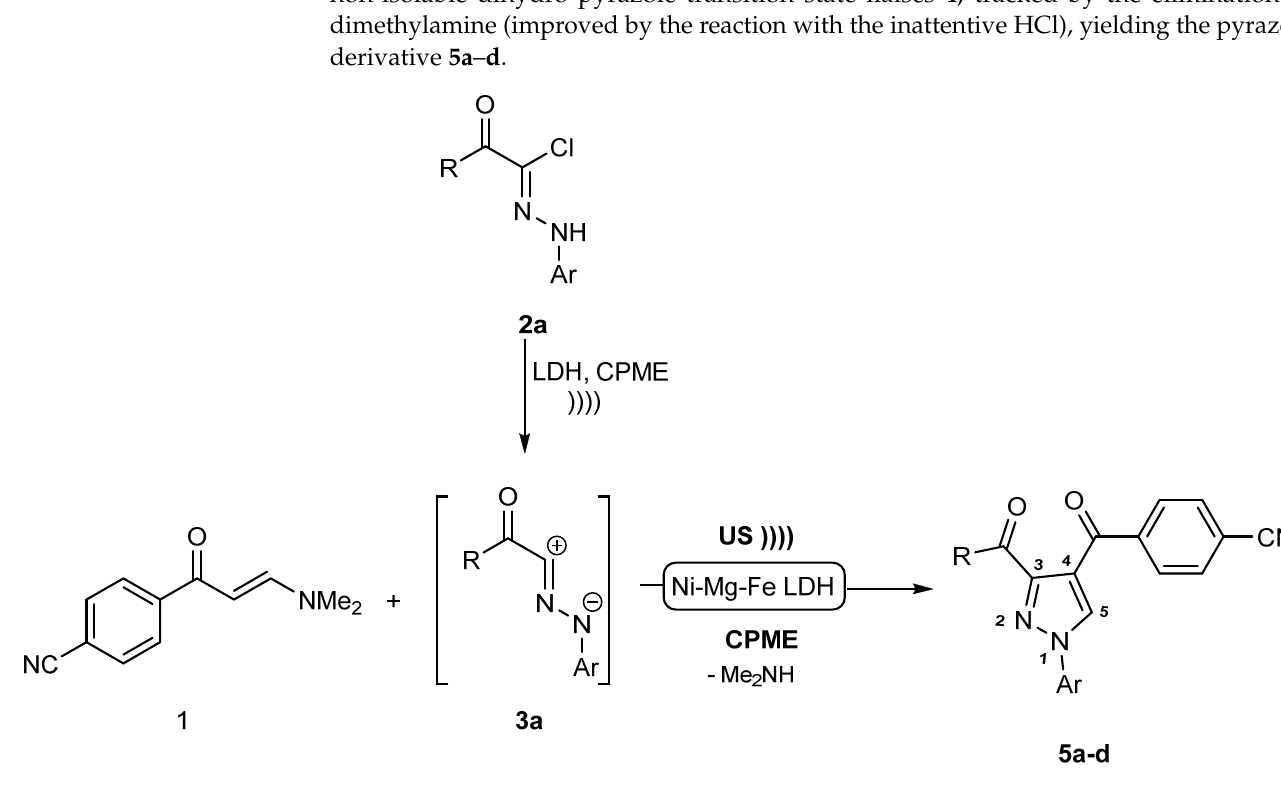
( − HCl)) (Scheme 1) to the stimulated double bond in the enaminone 1 to pay for the